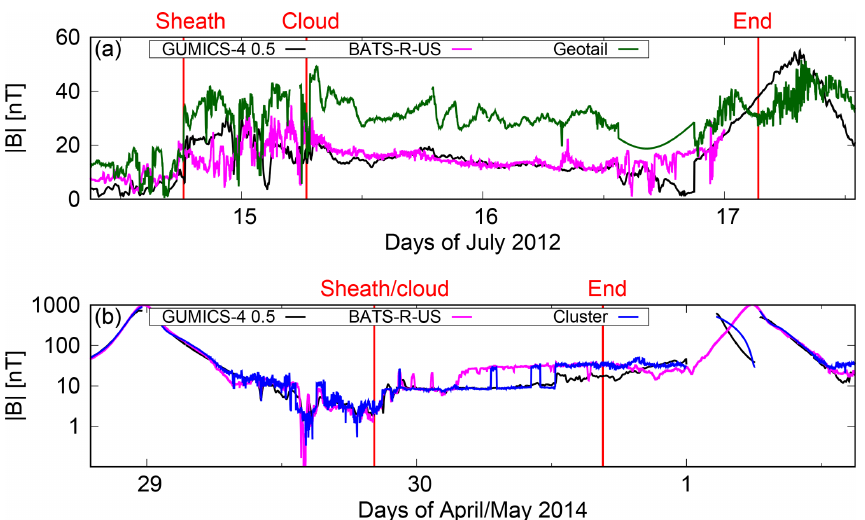
Figure 11. The time series of the magnetic field magnitude | B | along the orbits of Geotail during 14 July 09:00UT–17 July 15:00UT 2012 (a) and Cluster 1 during 28 April 19:00UT–1 May 17:00UT 2014 (b) as measured by Geotail (green) and Cluster 1 (blue) and predicted by GUMICS-4 (black) and BATS-R-US